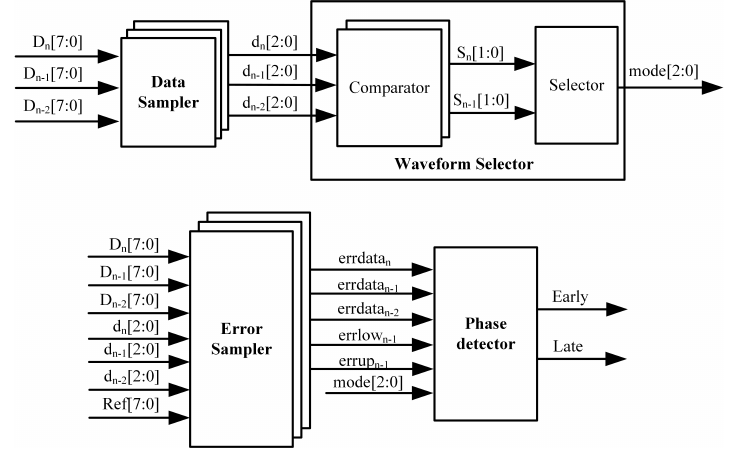
Figure 4. MMPD architecture of DB PAM-4. Table 1. Waveform classification of DB PAM-4.